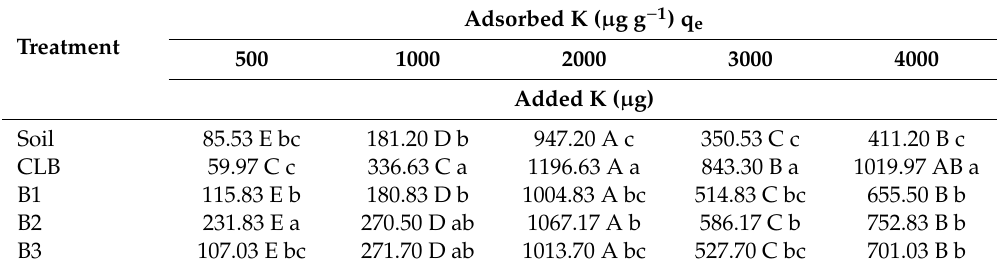
Table 10. Potassium addition to potassium adsorption based on di ff erent